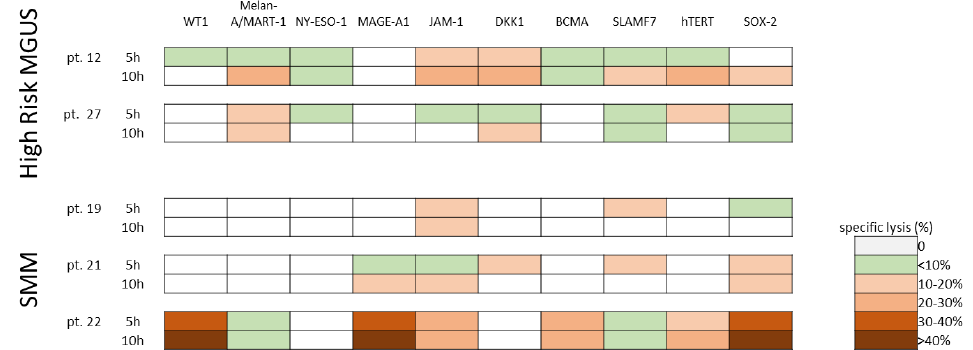
Figure 5. Cytolytic activity exerted by MMAA-specific CTLs. Cytotoxic activities of PBMCs from three high-risk MGUS patients and two SMM patients, after 15-day culture in the presence of peptide pools from 10 MMAAs, were tested against autologous PHA blasts pulsed with each MMAA separately. The results are represented as the percentage of specific lysis and were calculated after subtraction of background, consisting of cytotoxicity against autologous PHA blasts pulsed with control unrelated peptides. Heatmap shows the results of 5 h and 10 h cytotoxicity assays in each patient.